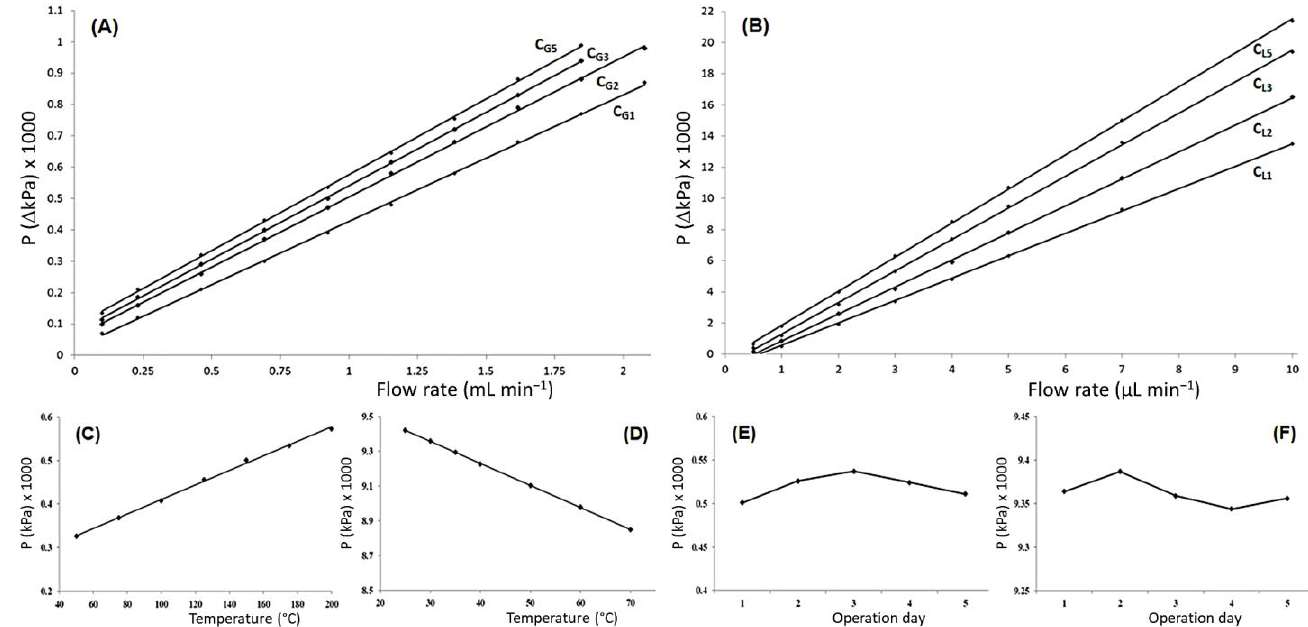
Figure 3. ( A ) Graph illustrating a plot of the pressure drop versus flow velocity using helium as a carrier gas in GC at 150 °C for the poly(GMA-co-EDMA) columns with/without MMT. ( B ) Graph illustrating a plot of the pressure drop versus flow velocity using an acetonitrile as mobile phase in nano-HPLC at 30 °C for the poly(GMA-co-EDMA) columns with/without MMT. ( C ) Pressure drop versus column temperature curve of helium as carrier gas at a flow rate of 0.926 mL min −1 for the MMT@poly(GMA-co-EDMA) column. ( D ) Pressure drop versus column temperature curves of acetonitrile as mobile phase at a flow rate of 5.0 μL min −1 for the MMT@poly(GMA-co-EDMA) column. ( E ) Graph illustrating plots of the pressure drop versus operation days as helium passed through the MMT@poly(GMA-co-EDMA) column at a 0.926 mL min −1 flow rate. ( F ) Graph illustrating plots of the pressure drop versus operation days as acetonitrile passed through the MMT@poly(GMA-co-EDMA) column at a 5.0 μL min −1 flow rate.